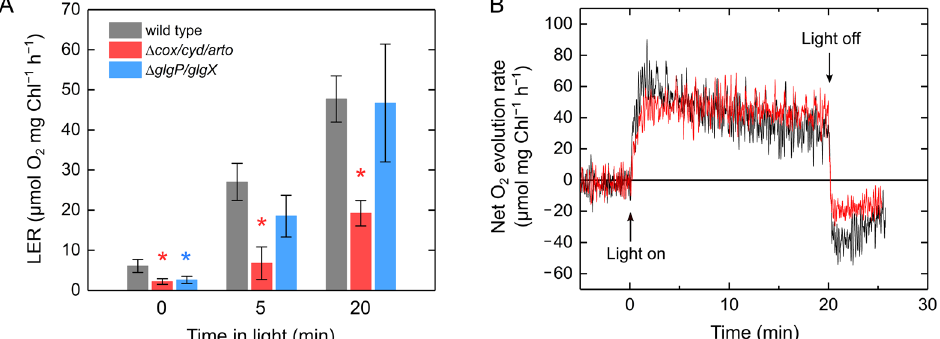
Figure 5. Light-enhanced respiration (LER) in wild type (grey bars) and the mutant of Synechocystis sp. PCC 6803 deficient in respiratory terminal oxidases ( ∆ cox/cyd/arto , red bars) and glycogen degradation enzymes ( ∆ glgP/glgX , blue bars) adapted to the darkness for 24 h. ( A ) LER after 20 min illumination with a red actinic light (190 µ mol photons m − 2 s − 1 ). Data are shown as the mean with the standard deviation ( n = 4, biological replicates). Asterisks indicate statistically significant differences ( p < 0.05) between wild type and the mutants as per Student’s t -test. ( B ) Representative comparison of the net O 2 evolution rate in the wild type (black) with that in the ∆ cox/cyd/arto (red).